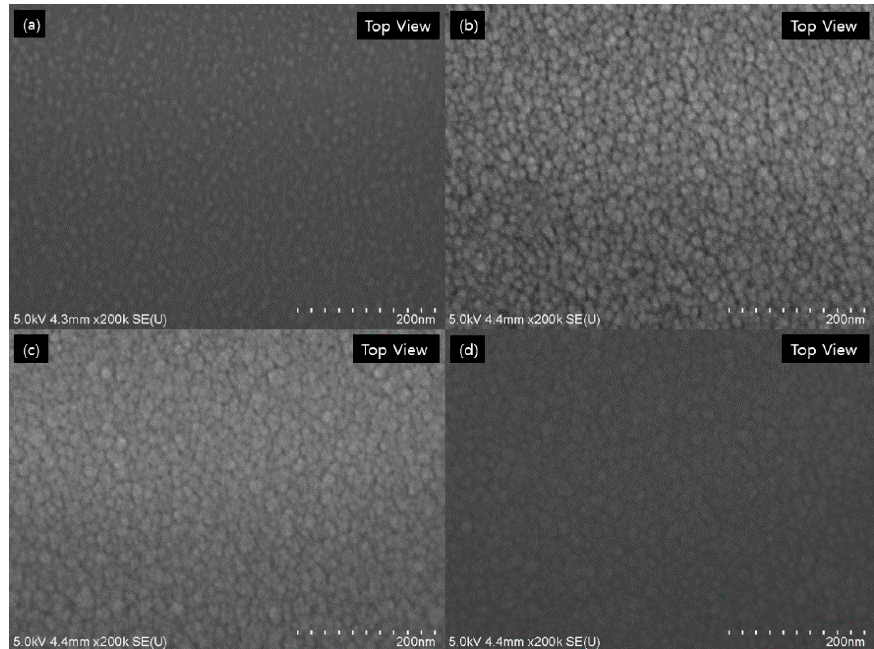
Figure 11. SEM images obtained at 200 k times magnification showing SiO 2 thin films deposited using various RF powers: ( a ) 50 W, ( b ) 100 W, ( c ) 150 W, and ( d ) 200 W.